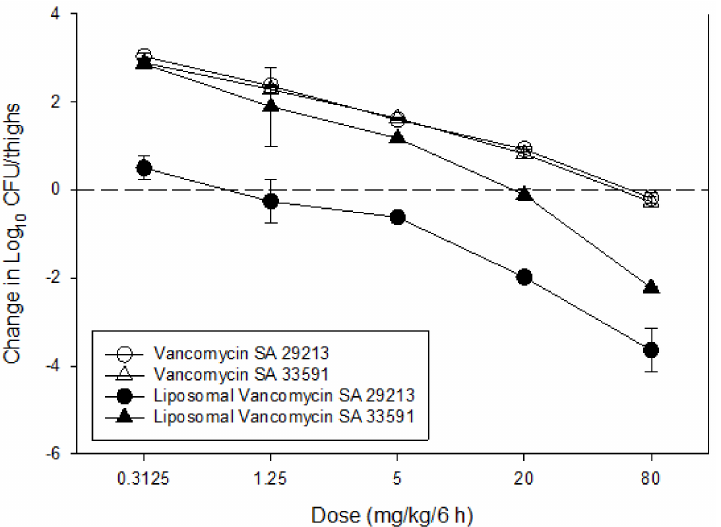
Figure 7. Superior bactericidal effect of LVAN in mice thigh infection model. LVAN shows bacteri- cidal effect at the dose of 1.25 and 20 mg/kg/6 h for MSSA and MRSA, respectively. VAN shows bactericidal effect at a much higher dose of 80 mg/kg/6 h for both MSSA and MRSA. This data strongly support the rationale for developing targeted LVAN-As for treating